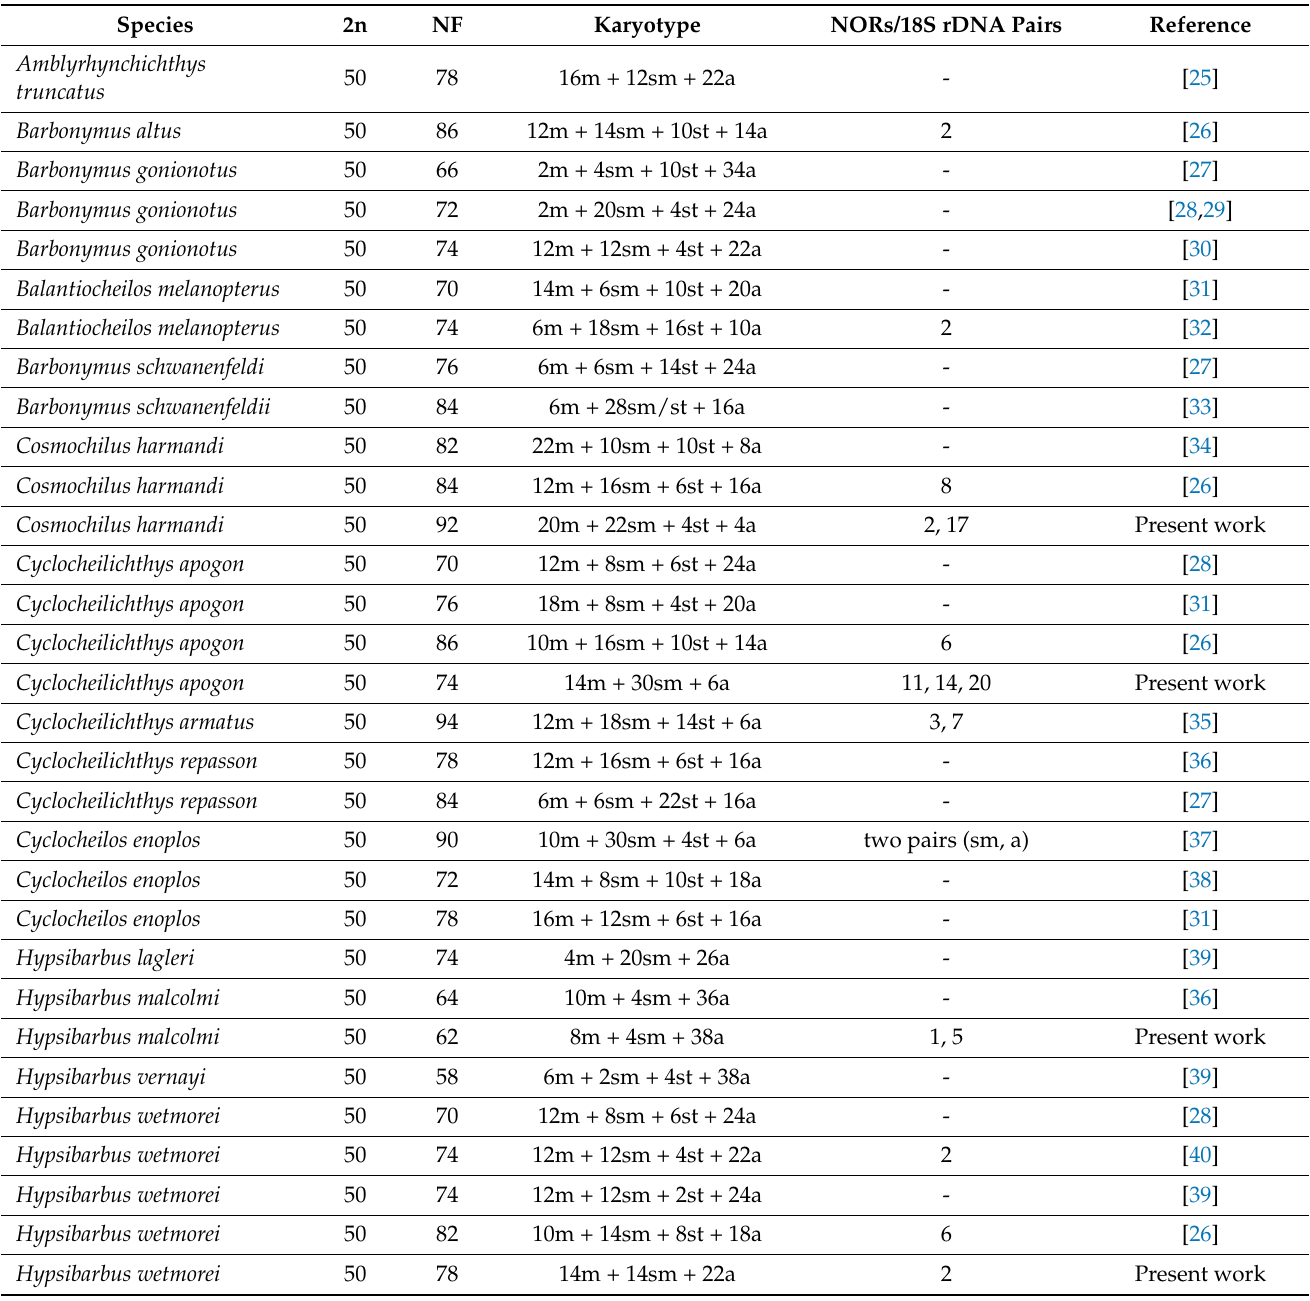
Table 1. Review of available cytogenetic data for representatives of ‘Poropuntiinae’ species analyzed up to now. The species analyzed in this study are highlighted in red. Chromosomes were classified following their arm ratios in m = metacentric, sm = submetacentric, st = subtelocentric, and a = acrocentric, and their fundamental number (NF, i.e., number of arms) are also displayed [24]. Nucleolar organizer regions (NORs)/18S rDNA carrying pairs are